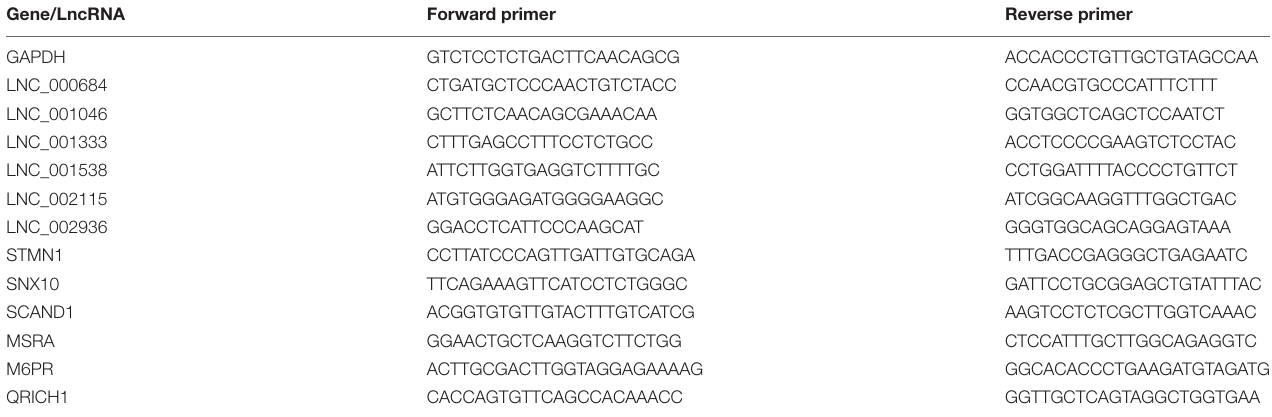
TABLE 1 | Summary of the oligonucleotide primer sequences.